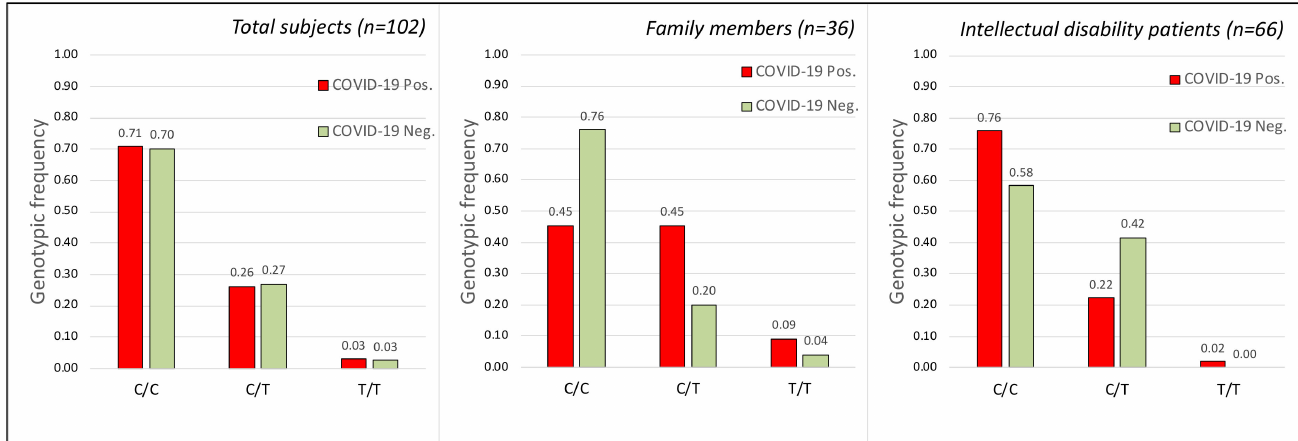
Figure 2. Frequency of the three genotypes obtained by the C and T alleles of the rs12329760 SNP polymorphism (TMPRSS2 gene) in the analyzed groups. ( Left ) Genotype frequency in the total subjects (Chi-square Test for 3 2: Chi = 1.282 p = 0.527 df = 2; Sample size = 102; power = 0.0922357). × ( Middle ) Genotype frequency in the subjects belonging to the analyzed families with cohabiting members (Chi-square Test for 3 2: Chi = 3.207 p = 0.2011 df = 2). ( Right ) Genotype frequency in the × subjects belonging to the intellectual disability patients cohabiting in the Oasi M. Santissima IRCCS (Troina, Italy). Each group was subdivided into infected (COVID-19 Pos.) and non-infected (COVID- 19 Neg.) groups. (Chi-square Test for 3 2: Chi = 2.0812 p = 0.353 df = 2). No statistically significant × correlation was obtained between SARS-CoV-2 infection and the rs12329760 SNP polymorphism.